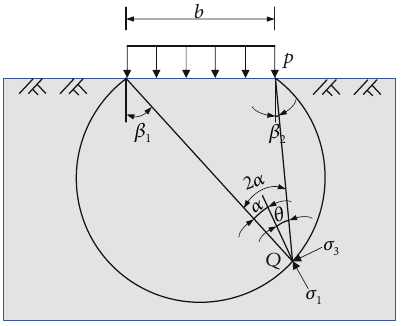
Figure 1: The isogram of principal stress under uniform strip